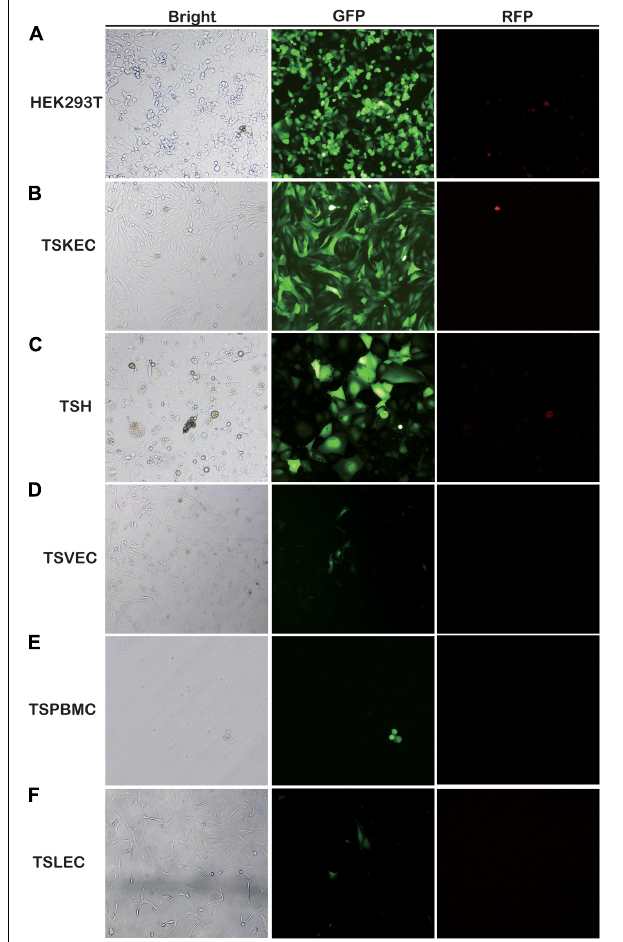
FIGURE 1 | Screening for rKSHV.219-susceptible infected primary cells from tree shrews. Primary cells were infected with rKSHV.219 (MOI = 10). Bright field, GFP and RFP fluorescence images were taken at 48 h. (A) HEK293T. (B) TSKEC. (C) TSH. (D) TSVEC. (E) TSPBMCs. (F) TSLEC. Original magnification,10 ×